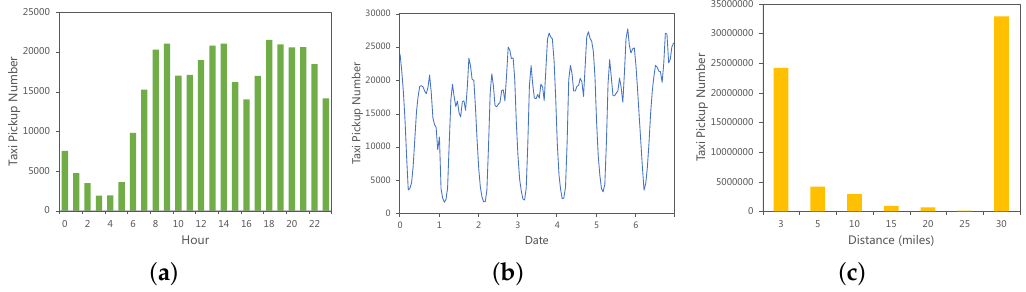
Figure 3. Distribution of New York City (NYC) Yellow Taxi Data. ( a ) The taxi pickup number in each hour of one day. ( b ) The taxi pickup number in each day of one week. ( c ) The grouped taxi pickup number at each distance range.